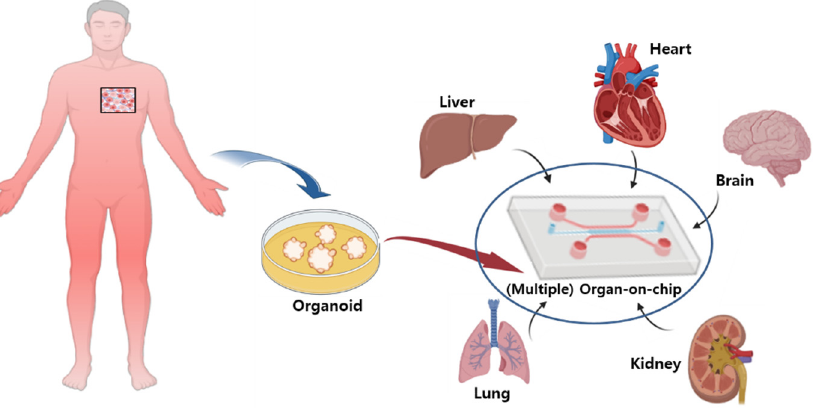
Figure 2. Multi “organ ‐ on ‐ chip” or microchip platform model for disease research. The organ ‐ on ‐ chip model mimics the physicochemical microenvironment of tissues in the human body. It is a microfluidic cell culture system with well ‐ controlled conditions applied to study various diseases.